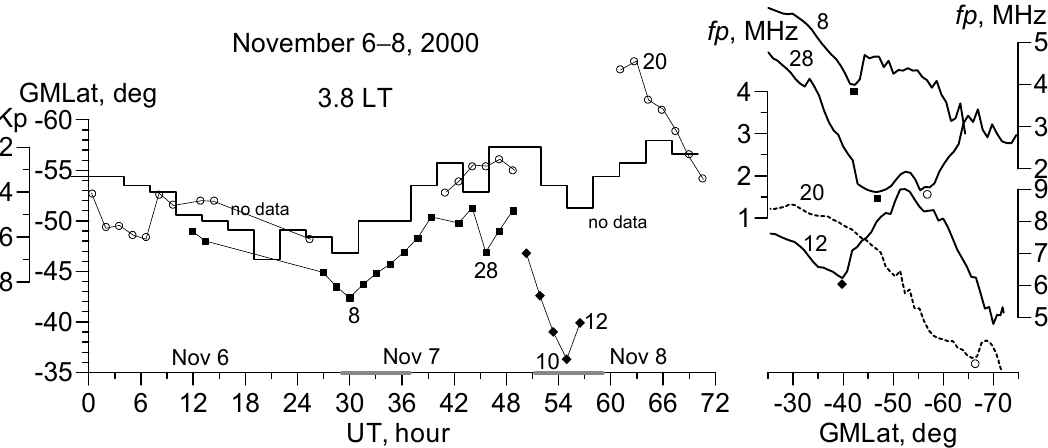
Figure 6. The variations in the MIT (circles), RIT (squares), and pseudo-trough (diamonds) position during 6–8 November 2000, in the Southern hemisphere at 3.8 LT. Horizontal thick line segments show longitudes with a weak geomagnetic field. The CHAMP passes are marked by the numbers. The time is counted from 00 UT on 6 November.